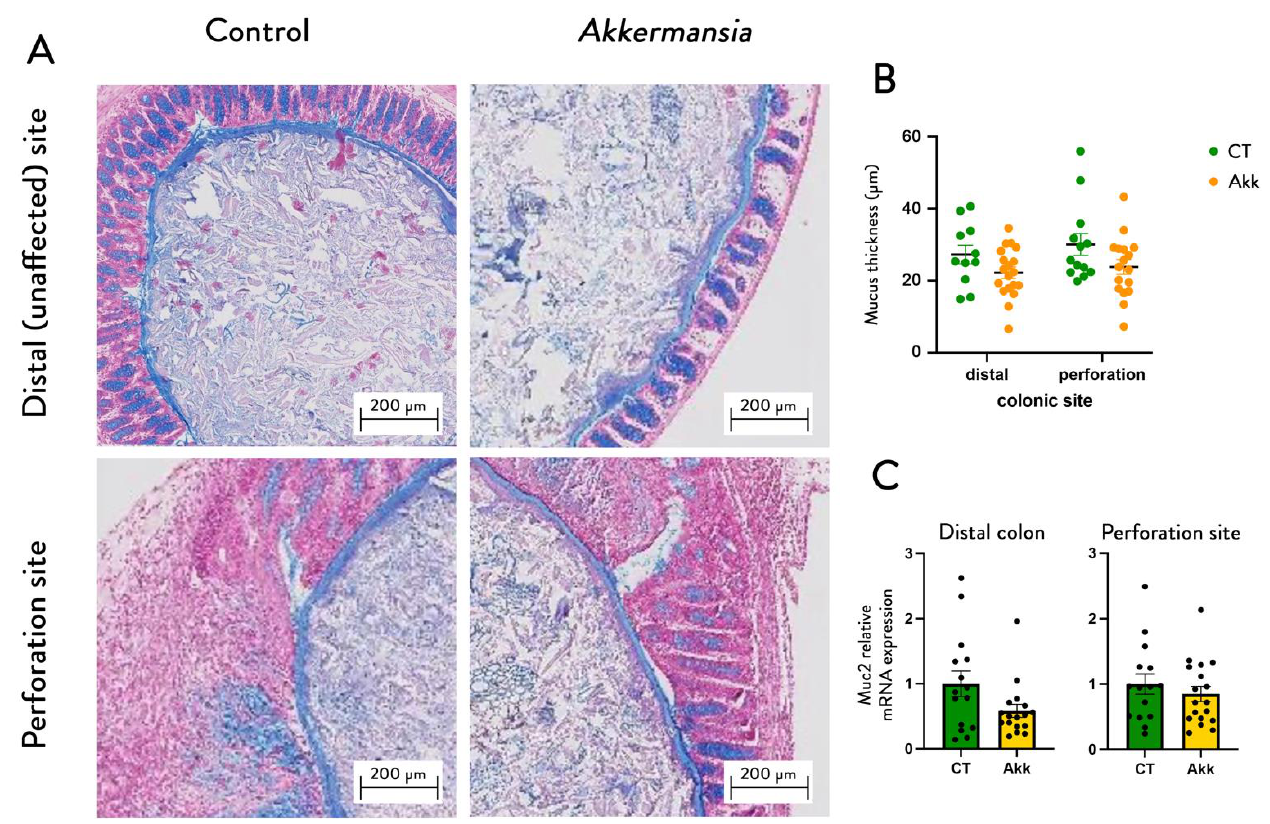
Figure 3. A. muciniphila administration does not affect mucus thickness and Muc2 expression. ( A ) Representative Alcian blue-stained images of the mucus layer in the distal colon and the perforation site of mice treated with or without A. muciniphila . ( B ) Mucus thickness measurements. ( C ) Relative mRNA expression of Muc2. Data are represented as mean +/− SEM and black dots (dotplots) represent individual values for each animal. Statistical difference assessed using non-parametric Mann – Whitney test, p -value > 0.05.